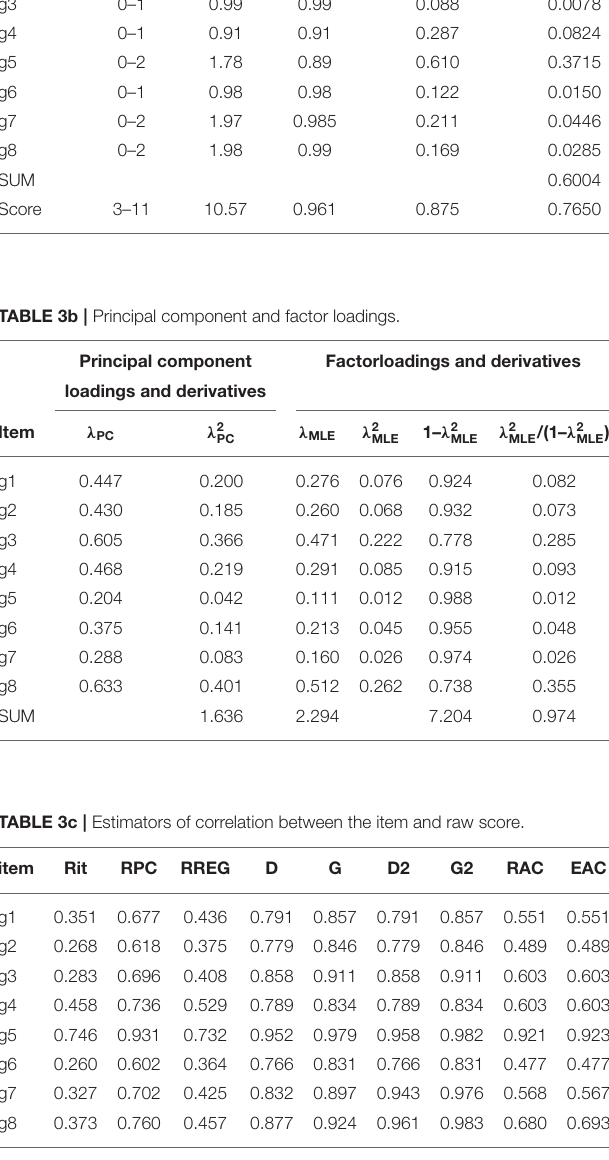
For the traditional alpha, theta, omega, and rho, their original score variable is used: a raw score for alpha, a principal component (PC) score for theta, and an ML estimate (MLE) of the factor score for omega and rho. For DCERs, the raw score is used as the manifestation of the latent variable; Metsämuuronen (2022f) shows examples of using PC and factor scores in